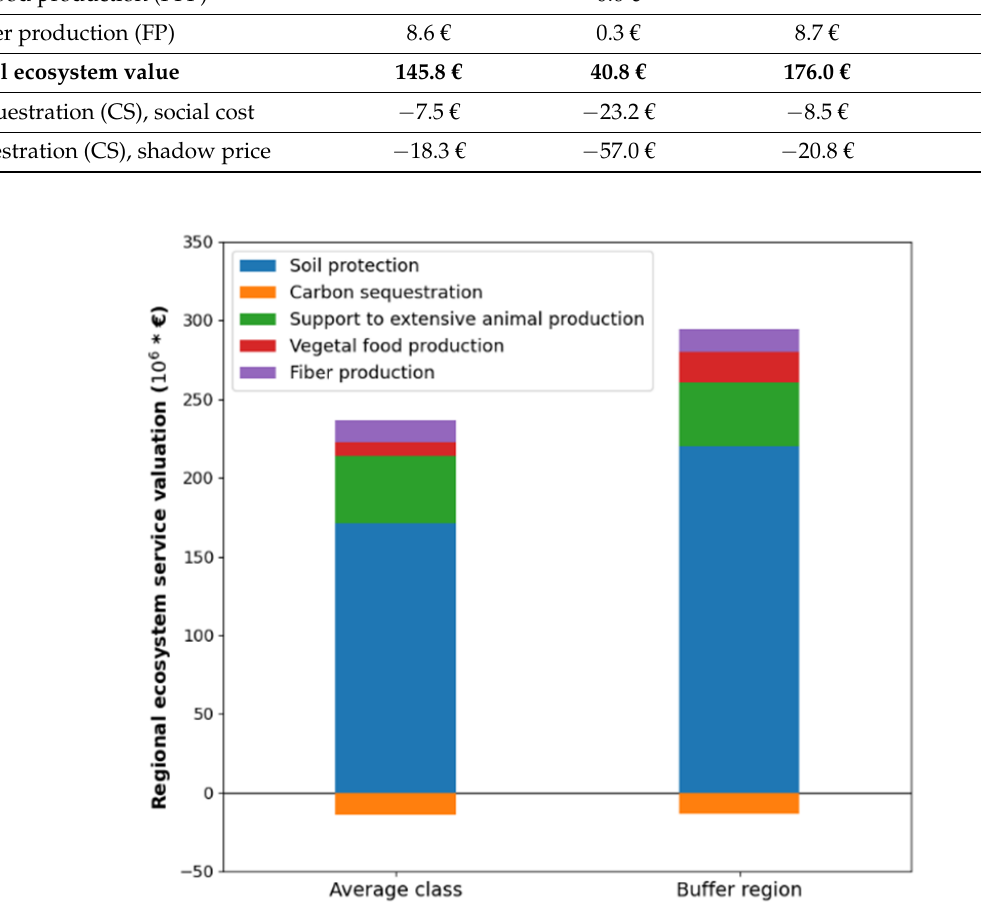
Figure 4. Estimated value of ecosystem services ( € ) from pasture-based beef farming in Alentejo after regional extrapolation for both modelling approaches .